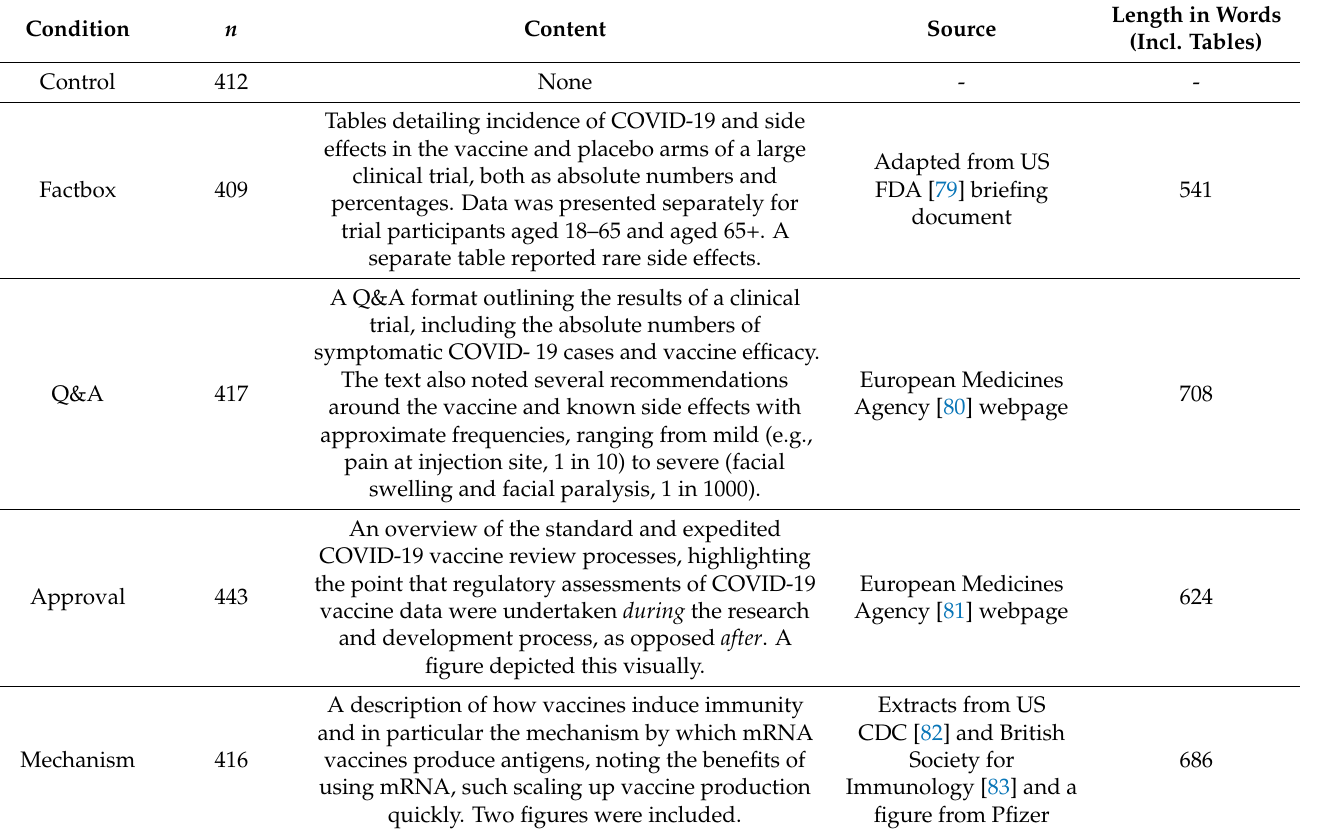
Table 1. Overview of message content in experimental